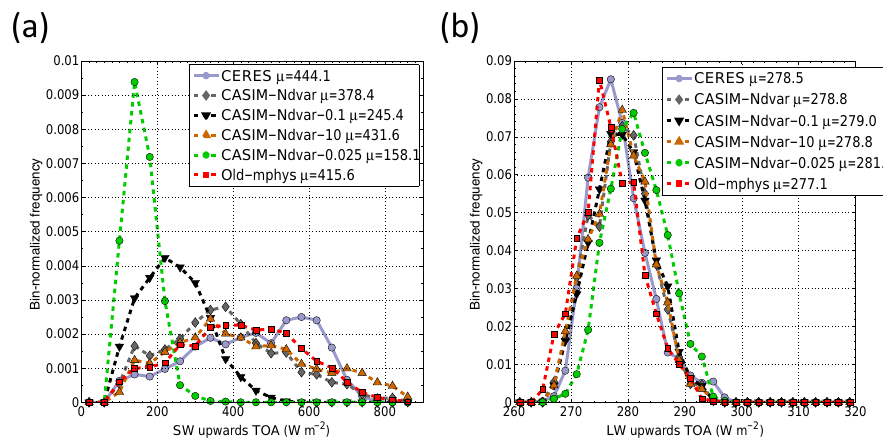
Figure 11. Shortwave (left) and long-wave (right) top of the atmosphere radiative flux PDFs from CERES and the model for daytime periods for the region of the model domain. This is a combined PDF from the three separate snapshot overpass times of the CERES satellite for the model domain that were available for the simulation period: 10:24LST (15:12UTC) on 12 November (Terra satellite), 14:19LST (19:06UTC) on 12 November (Aqua satellite), and 11:07amLST (15:55UTC) on 13 November (Terra). For the model, the three closest available times were used: 15:00 and 19:00UTC on 12 November 16:00UTC on 13 November. Note that CERES–Aqua data are not available for the afternoon (local time) of 13 November. The model data were first coarse-grained to 20km, which is the approximate resolution of the CERES